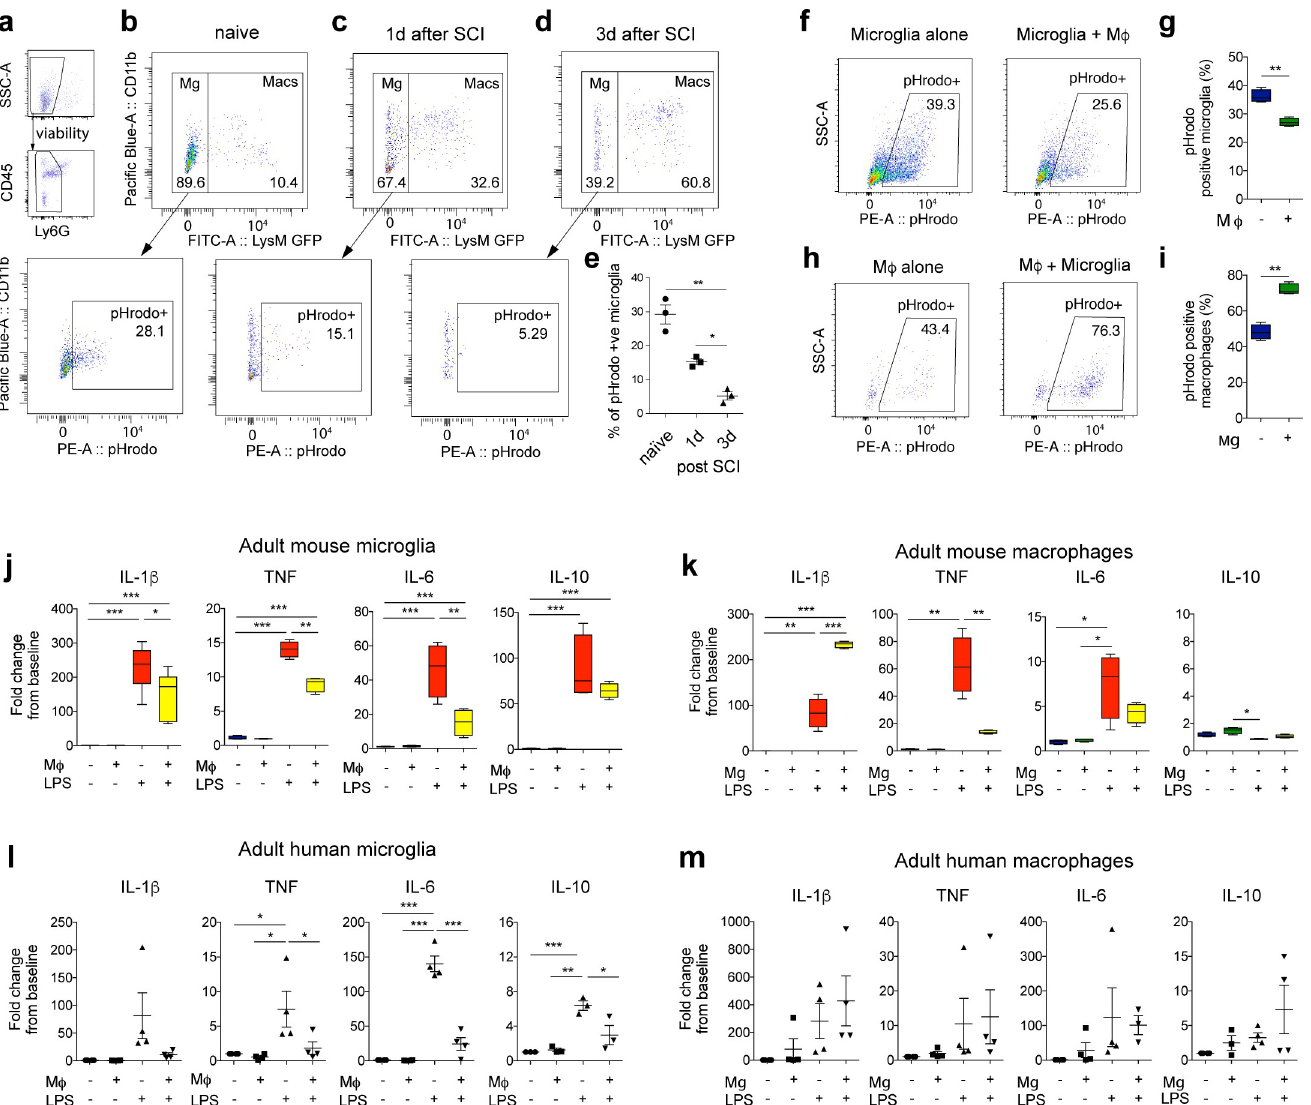
Fig 1. Reciprocal signaling between macrophages and microglia produces divergent functions in each cell type. ( a-e ) Increasing numbers of MDMs in the injured spinal cord correlates with reduced phagocytosis by microglia. Myeloid cells were isolated from the uninjured or injured spinal cord of LysM-eGFP mice and immediately treated with pHrodo- labeled myelin for four hours. ( a ) Flow cytometry gates to isolate microglia/macrophage populations exclude Ly6G+ neutrophils. ( b-d ) Representative flow cytometry dot plots show proportions of CD11b + /LysM-eGFP − ve (microglia) and CD11b + /LysM-eGFP +ve (macrophages) in uninjured or SCI tissue, 1 and 3 d after injury. Bottom panels show representative plots of microglia positive for pHrodo-myelin. ( e ) Graph shows reduced phagocytosis by microglia, with increasing presence of MDMs post-SCI. ( f-i ) In vitro bilaminar coculture of adult mouse microglia and macrophages. Representative FACS plots show uptake of pHrodo-labeled myelin in microglia ( f ) or macrophages (M ϕ ) ( h ) alone (left panels) or cells in coculture (right). Graphs showing that phagocytosis is significantly decreased in microglia in the presence of M ϕ compared to microglia alone ( g ), and significantly increased in macrophages in the presence of microglia ( i ). ( j-m ) The bilaminar culture system was used to assess microglia–macrophage communication on inflammatory gene expression in adult mouse and human cells. ( j ) Adult mouse microglial gene expression of four key inflammatory cytokines (IL-1 β , TNF, IL-6, and IL-10) treated with LPS (100 ng/mL) in the presence or absence of macrophages (M ϕ ). ( k ) Adult mouse macrophage gene expression in the presence or absence of adult mouse microglia. (l ) Adult human microglial gene expression in the presence or absence of human macrophages. ( m ) Adult human macrophage gene expression in the presence or absence of adult human microglia. Statistical analysis for ( e ), one-way ANOVA with Bonferroni corrections ( n = 3); ( g, i ) Student t test ( n = 4). ( j-m ) Two-way ANOVA with Bonferroni corrections ( n = 3–6), mean ± SEM, � p < 0.05; �� p < 0.01; ��� p < 0.001. Corresponding raw data ( S1 Data ). FACS, fluorescently activated cell sorting; IL, interleukin; LPS, lipopolysaccharide; MDM, monocyte-derived macrophage; SCI, spinal cord injury; TNF, Tumor necrosis